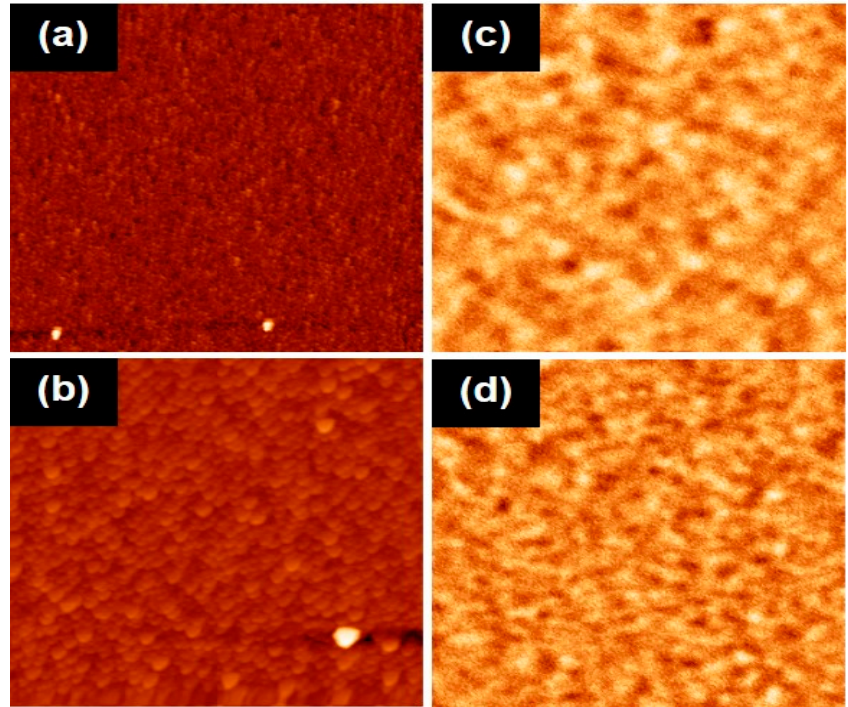
Figure 7. Surface morphology of the FePt films ( a , c ) without and ( b , d ) with MgO additive nanolay- ers, respectively, which were measured by the AFM ( left ) and MFM ( right ) modes. The scan area is 2 × 2 μ m 2 .